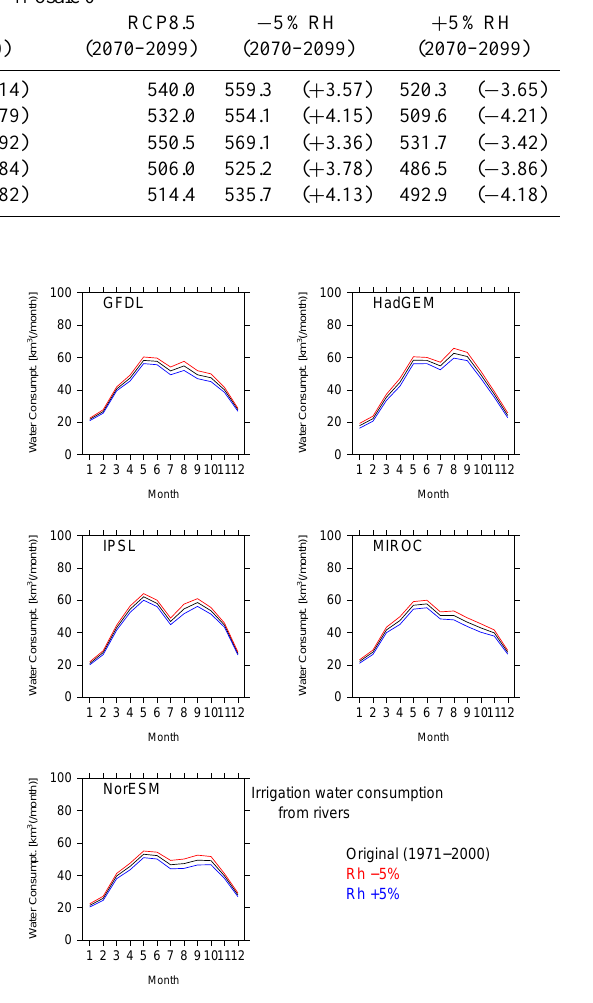
Figure 11. Monthly profiles of the global sum of present and fu- ture irrigation water consumption from rivers (IWCR). Black, blue and red lines show the results of the present (1971–2000) estima- tion and future (2070–2099) projections under RCPs 2.6 and 8.5, respectively.